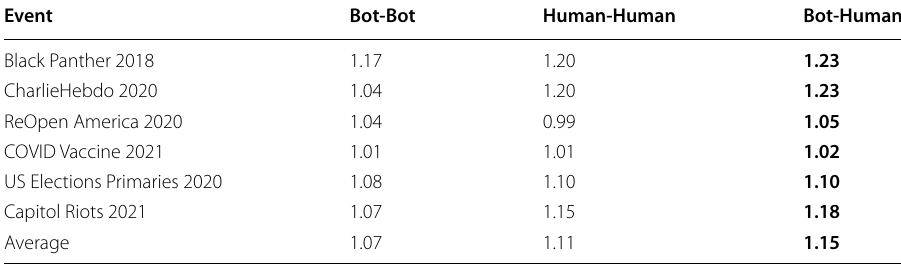
Values in Bold indicate the highest average CSI-UserPair by user pair types